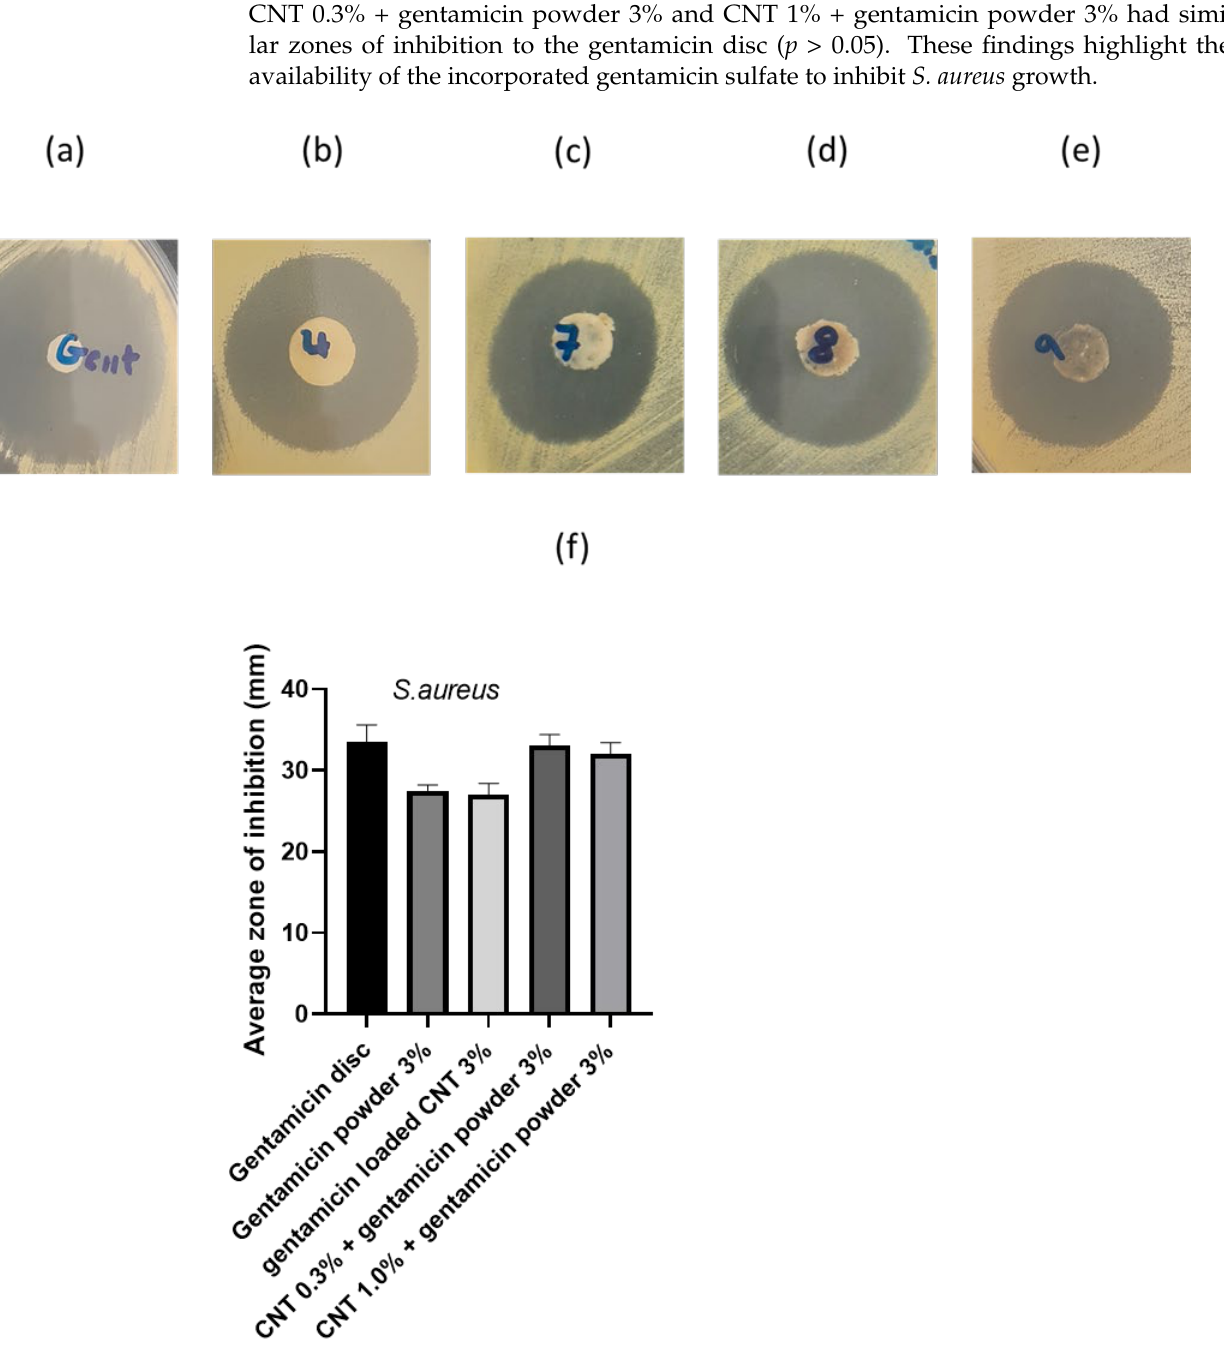
Figure 8. Zones of inhibition for S. aureus : ( a ) 10 μg gentamicin disc, ( b ) gentamicin powder 3%, ( c ) gentamicin-loaded CNT 3%, ( d ) CNT 0.3% + gentamicin powder 3%, ( e ) CNT 1% + gentamicin pow- der 3%, ( f ) average zone of inhibition ( n = 3 ± SD).